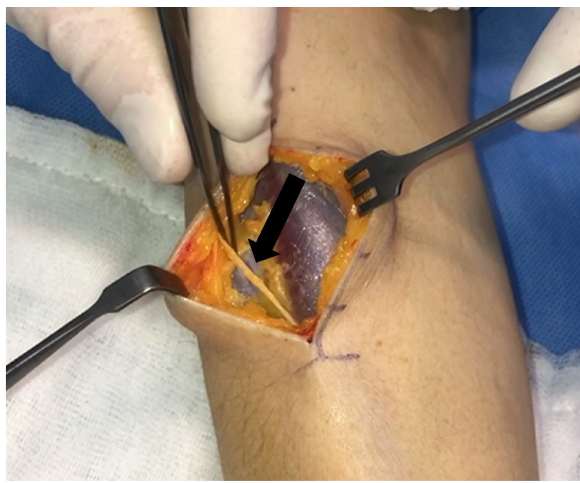
Figure 1. Cutaneous nerve (black arrow) is identified and protected with skin retractor.